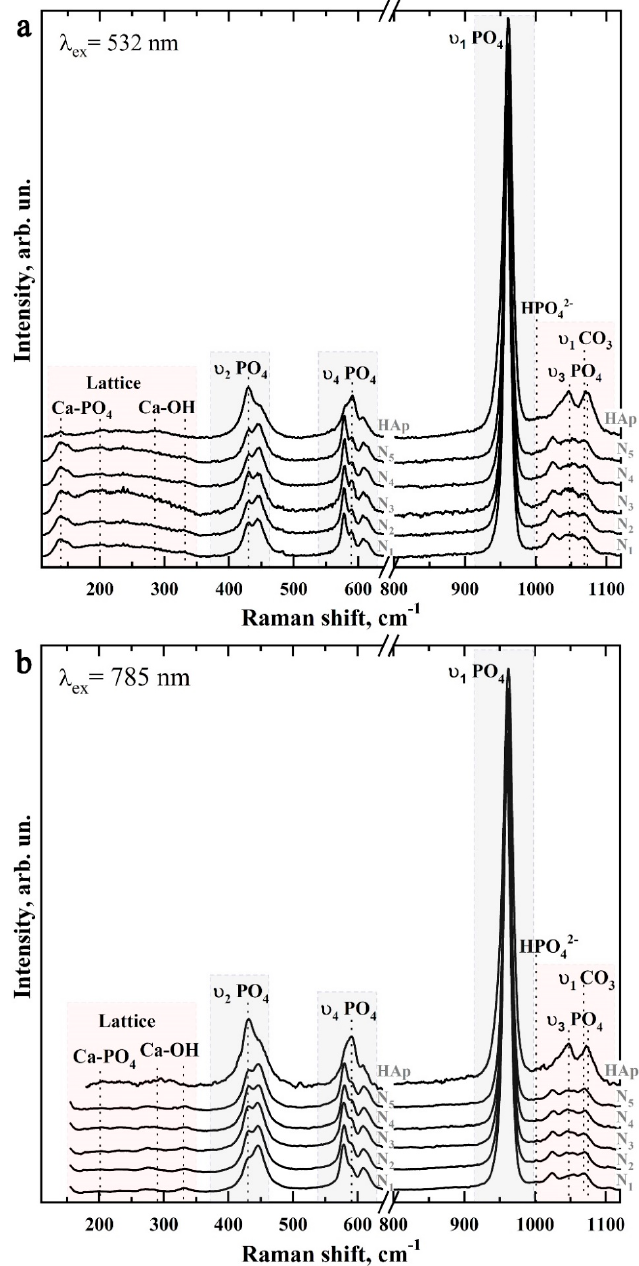
Figure 8. Typical Raman spectra of the studied samples: ( a ) excitation using 532 nm laser radiation; ( b ) excitation using 785 nm laser radiation.